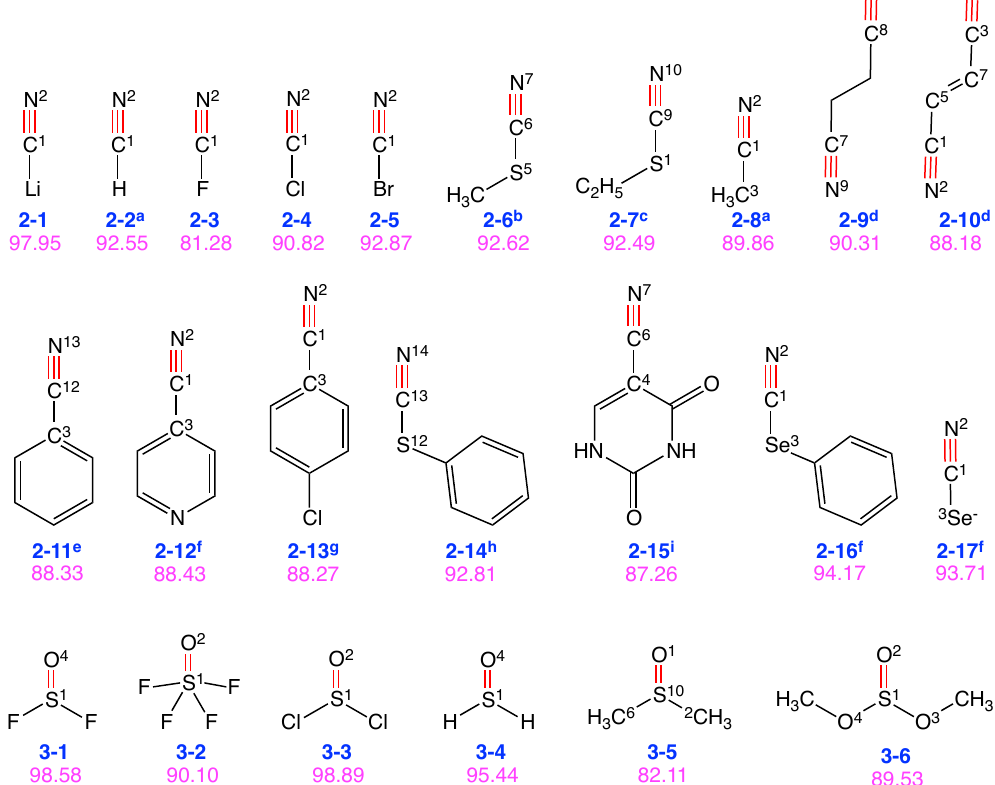
Figure 6. Group 2: 17 VSE probes with C ≡ N probe bonds in red. Group 3: 6 VSE probes with S = O VSE probe bonds in red. Below each structure, a label as n-m is given in blue, n denotes the group number (reflecting the type of VSE probe bond), and m is the number of this molecule in this group. Vibrational probe labels with superscripts are taken from the literature (a [4,10,50,51], b [10,18,24,27], c [24], d [18,50], e [5,10,18,26,27,50], f [18], g [26,50,51], h [102], i [20]). The corresponding performance score as VSE probe is given in purple. The number in superscript refers to atom index in the molecule. The superscripts are shown only for the atoms whose associated local modes participate in the S = O or C ≡ N normal mode with more than 5%